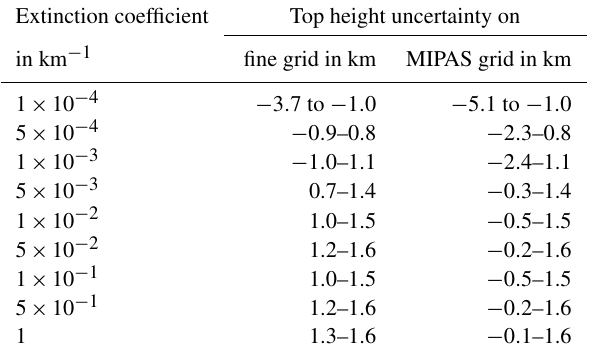
Table 2. Range of cloud top height uncertainty as a function of the extinction coefficient derived from the simulations. The cloud top is the altitude where ACI < 7. The results are given on the 0.1km fine grid of the simulations and transferred to the 1.5km vertical sampling of MIPAS. Please see the text for